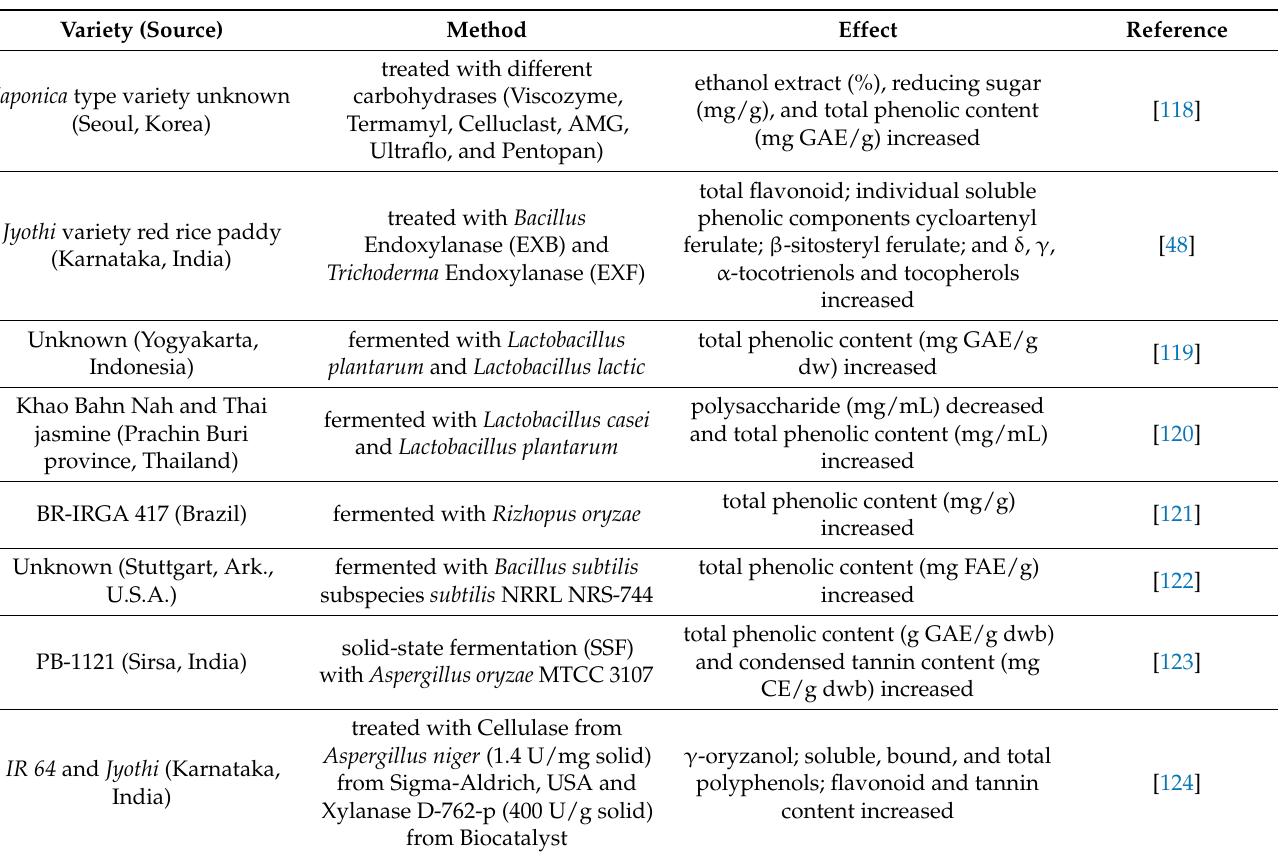
Table 1. Enhancement of The Antioxidant Capacity Method in Rice